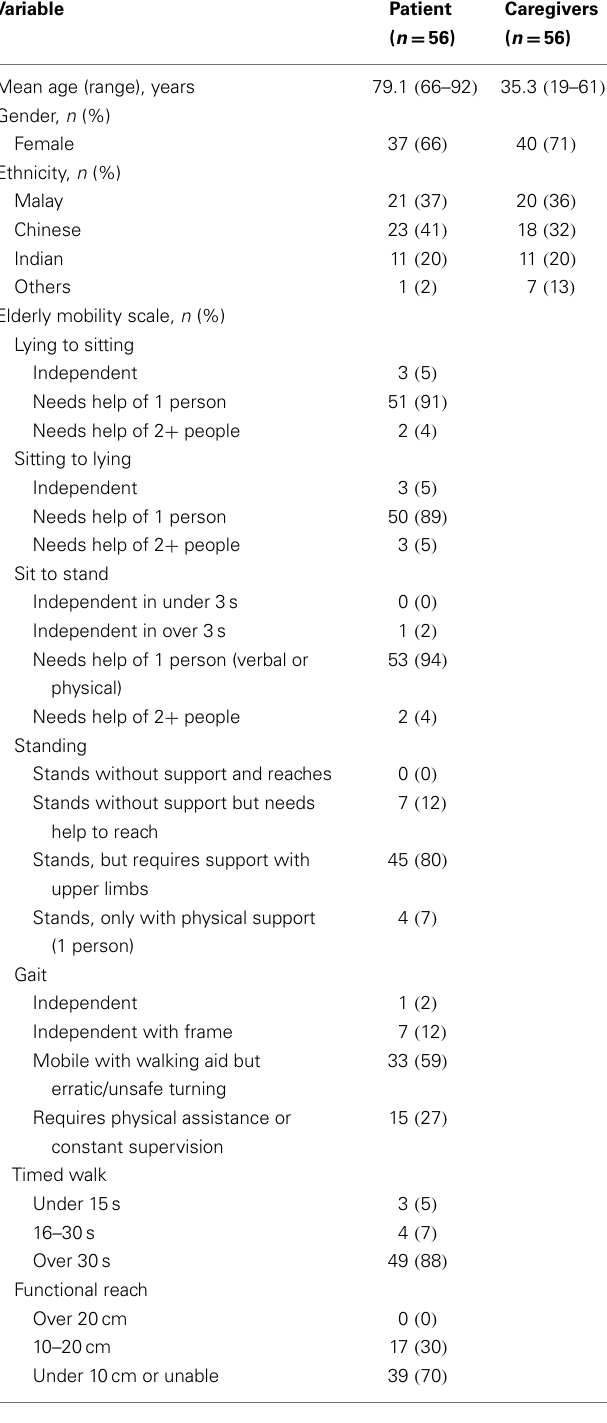
Table 1 | Demographic data and elderly mobility scores